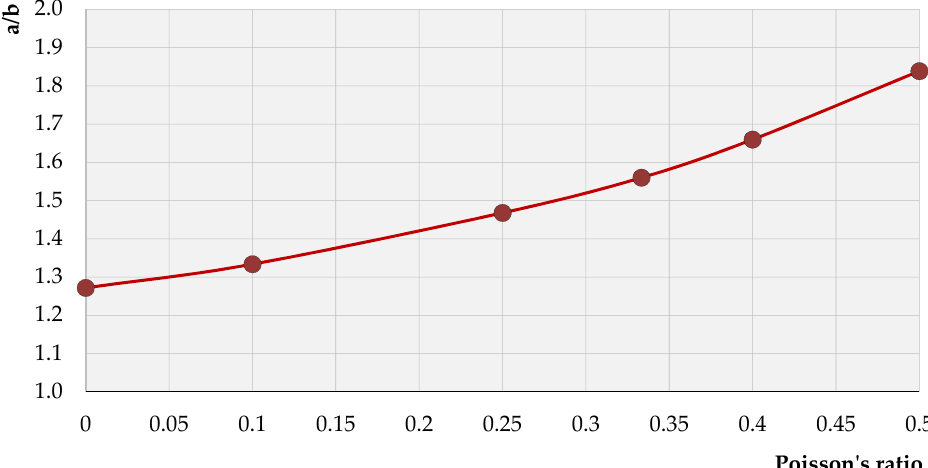
Figure 10. The ratio of the major to the minor axes of the ellipse in the function of Poisson’s ratio ( ν)..